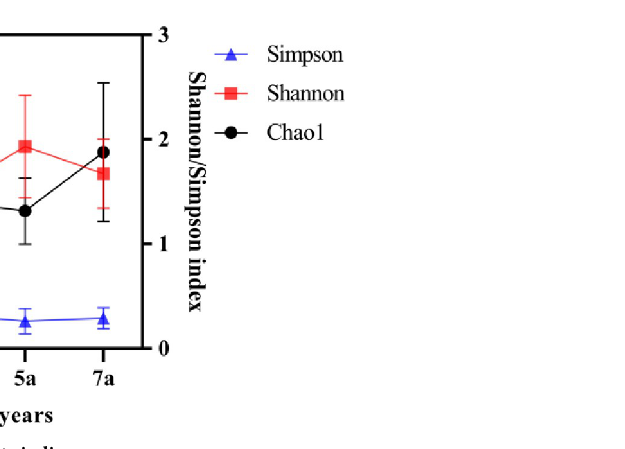
Fig 5. Changes of alpha diversity indices.